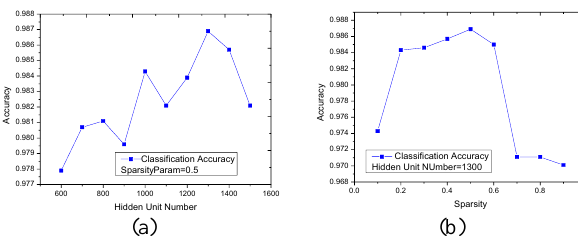
Figure 8 Parameter analysis for the hidden unit number and sparsity parameter with the KSC